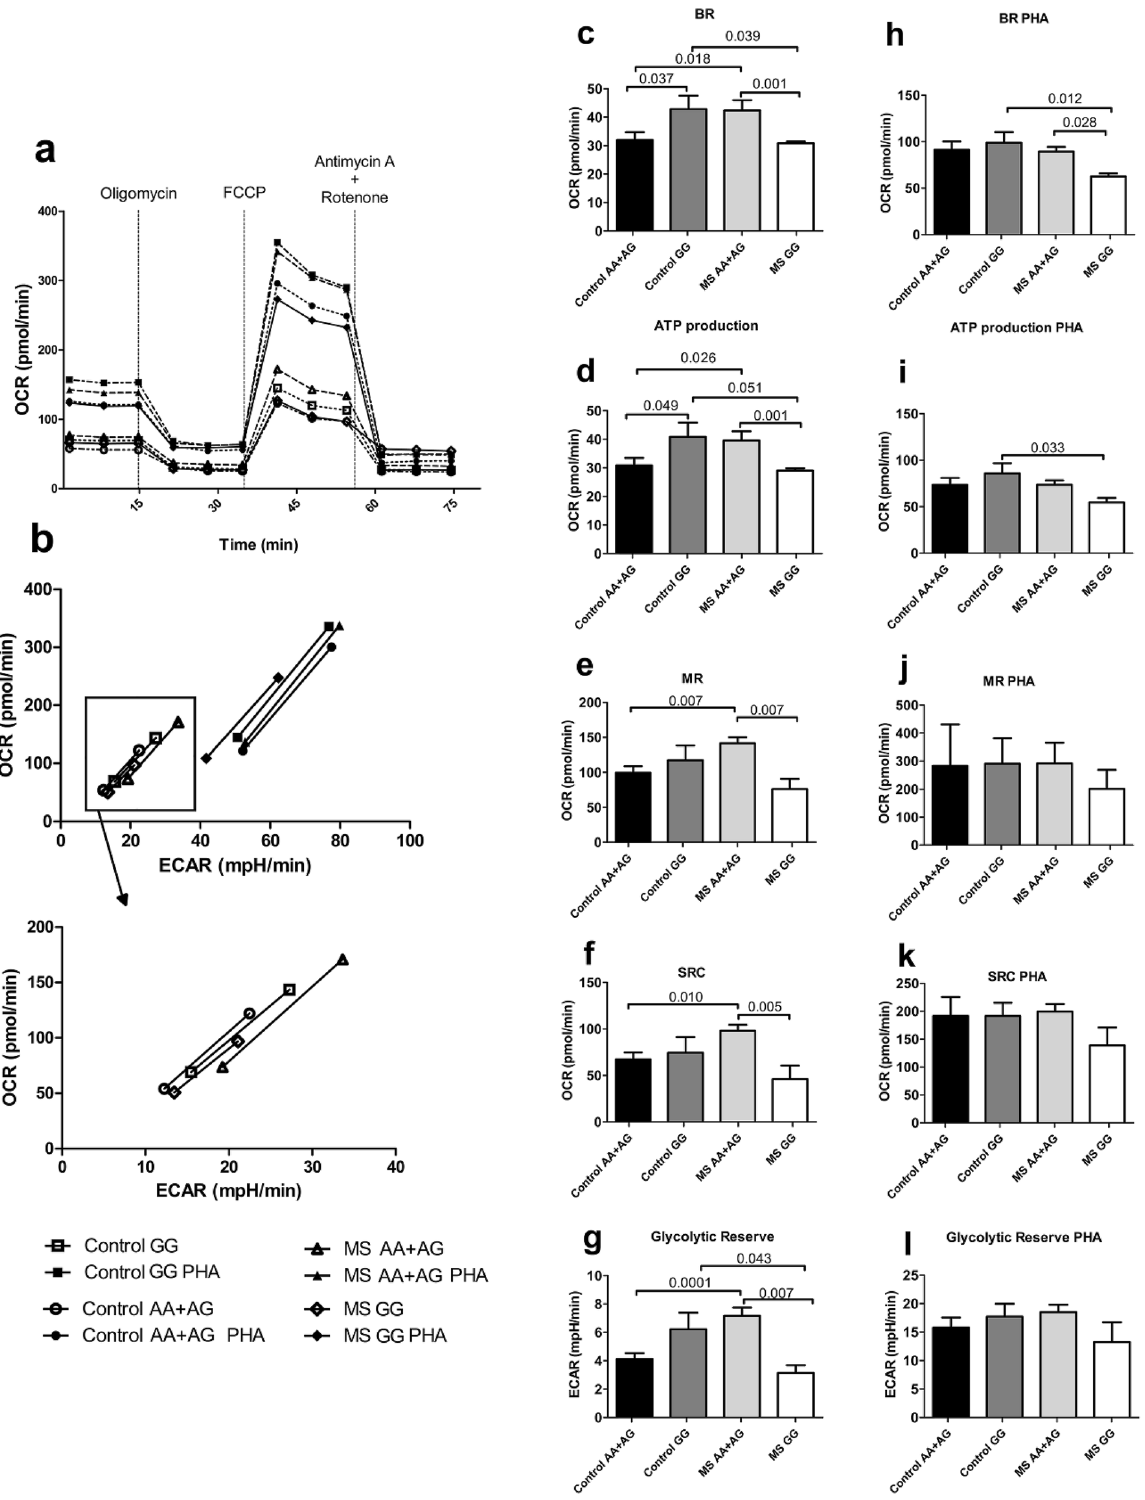
Figure 4. Effect of rs4912622 on lymphocyte metabolism. ( A ) Oxygen Consumption Rate (OCR) profile of PBMCs stimulated or not with PHA from controls or MS patients according to their rs4912622 genotype. ( B ) Energy Phenotype. A zoom out of unstimulated values is shown to improve visibility. ( C-G ) Basal Respiration (BR), ATP Production, Maximal Respiration (MR), Spare respiratory capacity (SRC), and Glycolytic reserve of unstimulated PBMCs. ( H-L ) The same parameters as in ( C-G ) are represented for PBMCs stimulated with PHA. Means ± standard deviations are shown (controls AA + AG: n = 12; controls GG: n = 7; MS AA + AG: n = 21; MS GG: n =